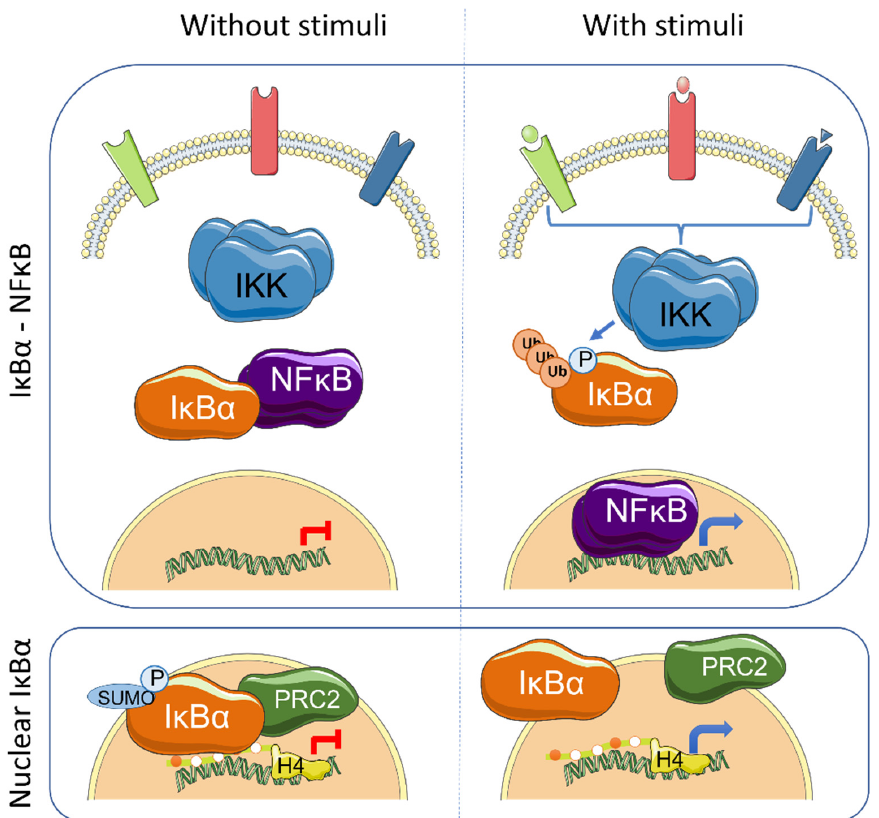
Figure 1. Graphical representation of the main I κ B α -regulated pathways: NF- κ B and nuclear SUMOylated I κ B α . Left panels show the status of the involved elements under unstimulated conditions whereas right panels indicate changes produced after cytokine induction.